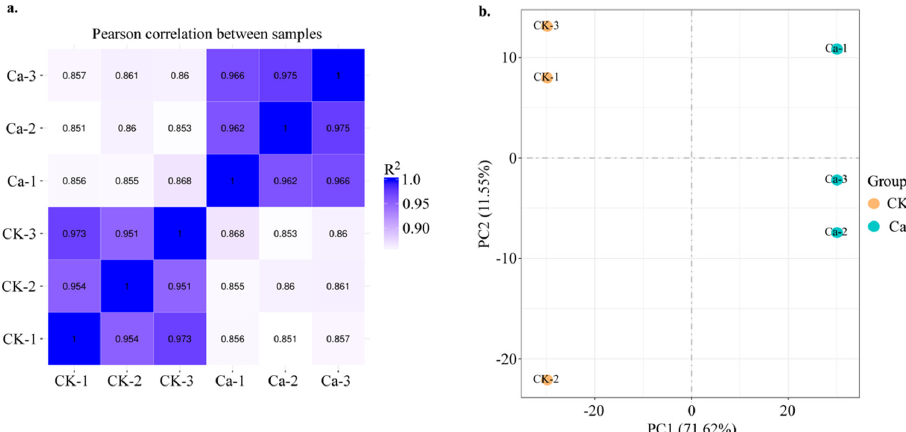
Figure 2. Pearson correlation and PCA analysis. ( a ) Pearson correlation between samples. ( b ) Principle component analysis between samples.